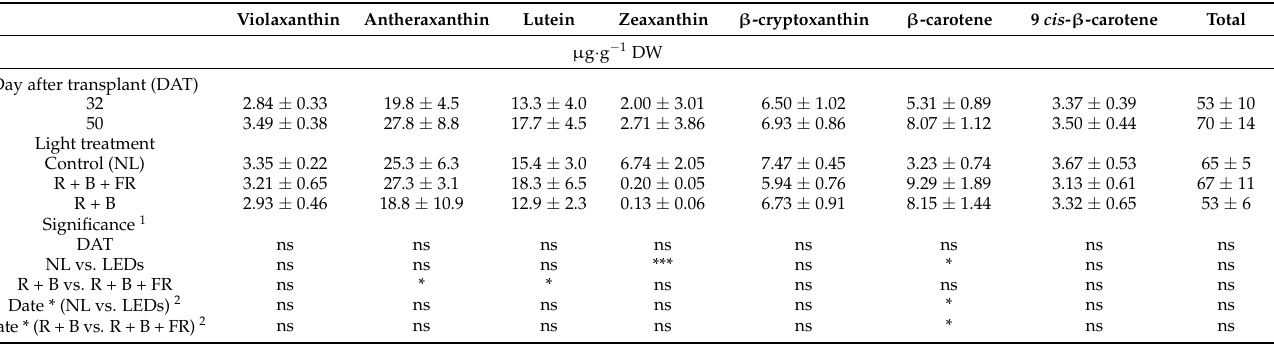
the zeaxanthin content was 6.74 µ g · g − 1 DW—that is, higher than the value observed in the fruits harvested under LEDs. The results underwent analysis of variance as described in methods and showed that the total carotenoid content of Carosello leccese was not signifi- cantly influenced by light treatments or harvest time and had on average 61.7 ± 7.5 µ g · g − 1 DW (Table 3). Table 3. Carotenoid profiles of the fruits of a landrace of Cucumis melo L. (“Carosello leccese”) from plants grown under solar light (NL, no supplementary lighting) and two different light spectra (see Figure 1). Values are average ± SD of three replications.